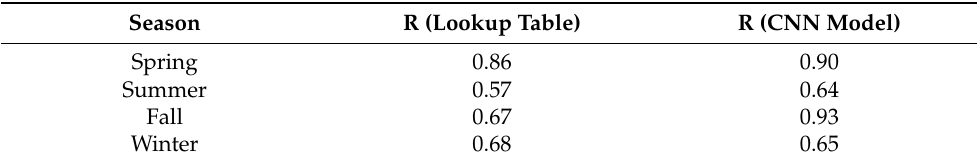
Table 4. The correlation coefficient between traditional inversion and level prediction. Season R (Lookup Table) R (CNN Model) Spring 0.86